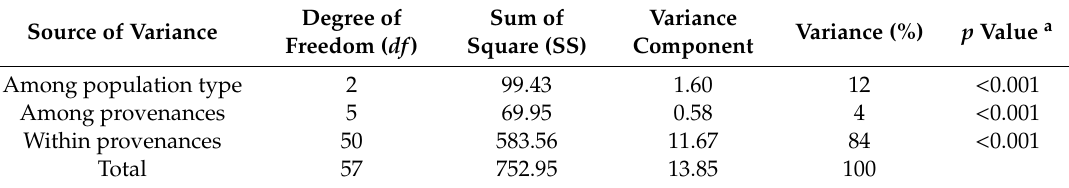
Table 5. Results of the analysis of molecular variation (AMOVA) of 58 G. crinita individuals representing three population types and eight provenances.